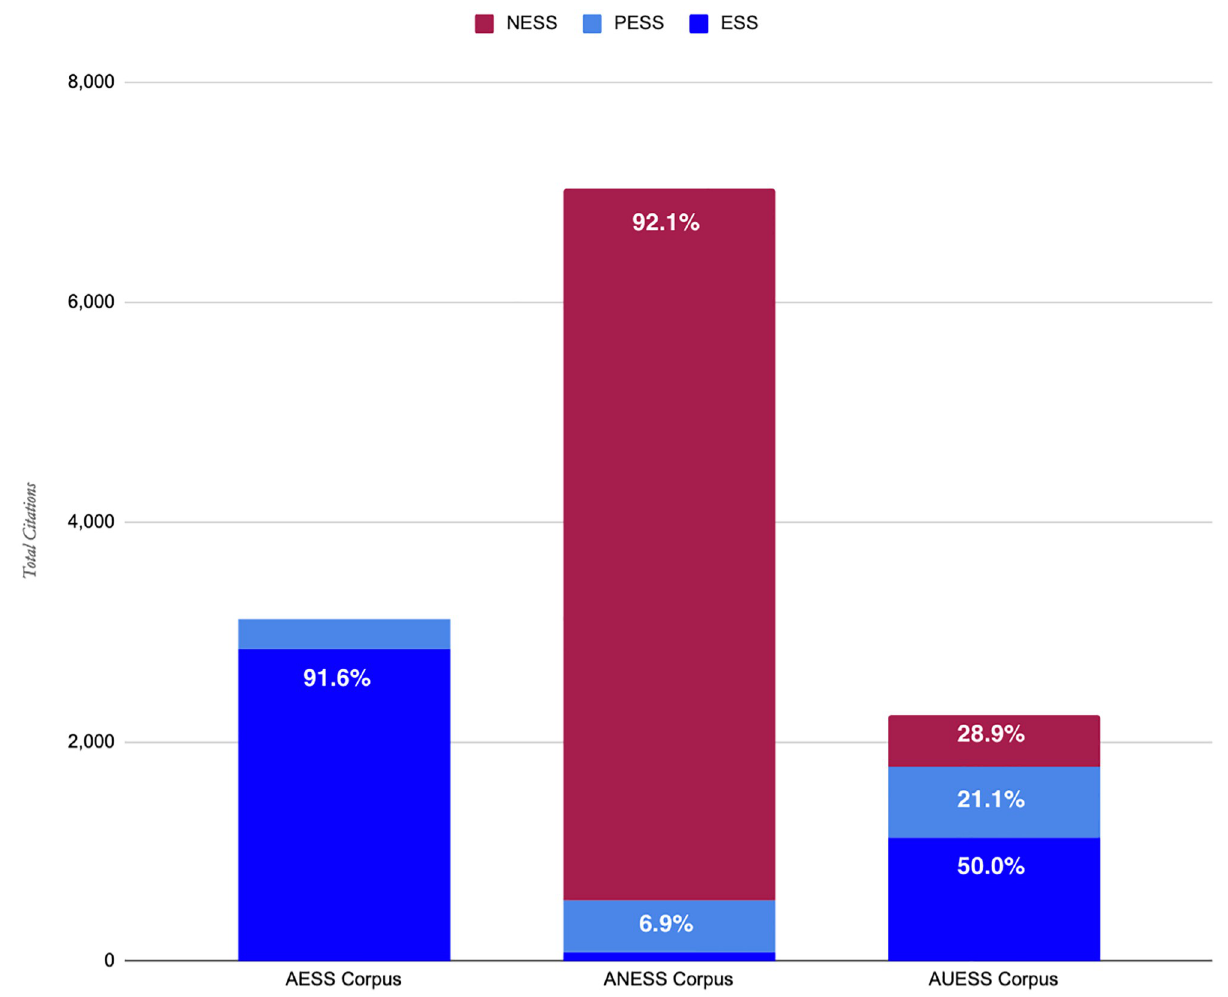
Fig 3. Probable composition of the final three corpora (subsets of the Agroecology Corpus 2019).